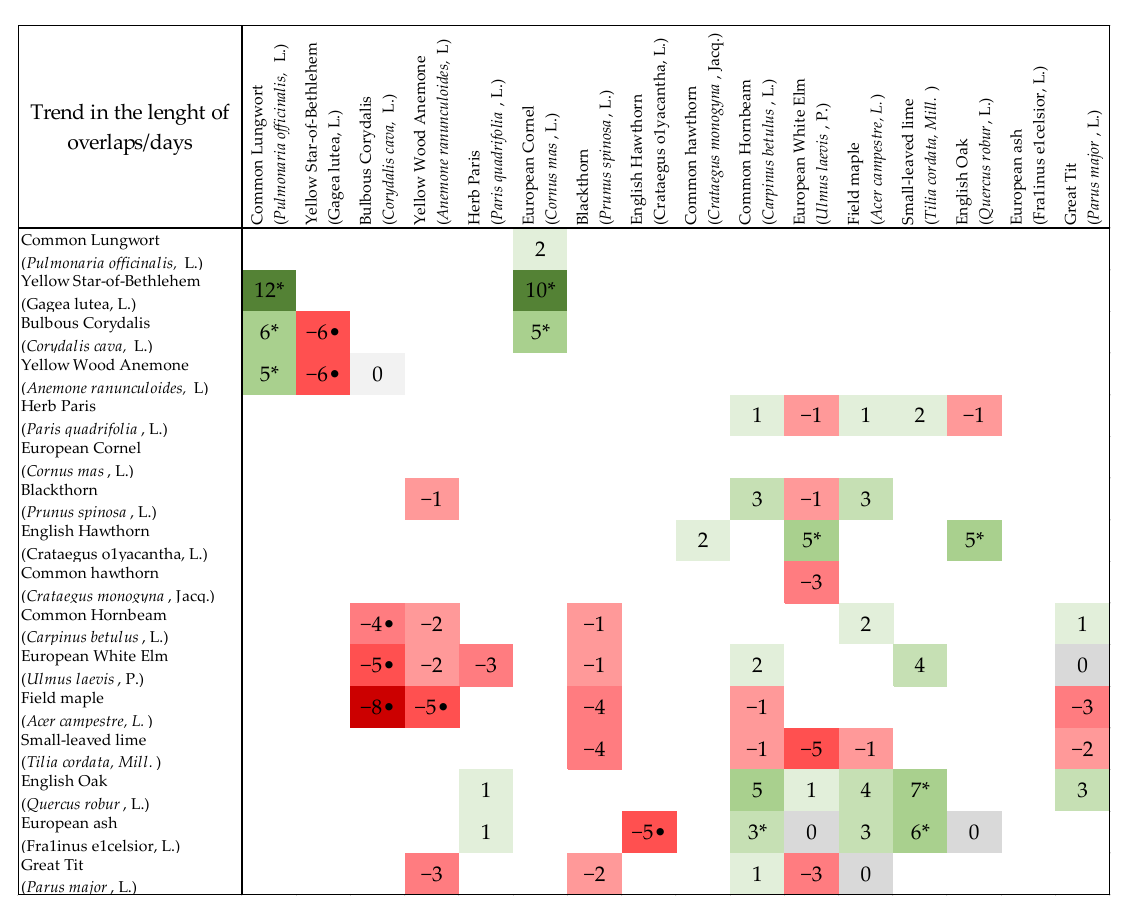
Figure A1. Trend in the length of overlap (days) among 62 phenological stages in total. Asterisks indicate a significant lengthening of overlaps; points indicate significant shortening of overlaps. The green colour indicates the lengthening of overlaps, and the red colour indicates the shortening of overlaps. Positive values indicate the number of days by which the overlaps were extended. Negative values indicate the number of days by which the overlaps were shortened.